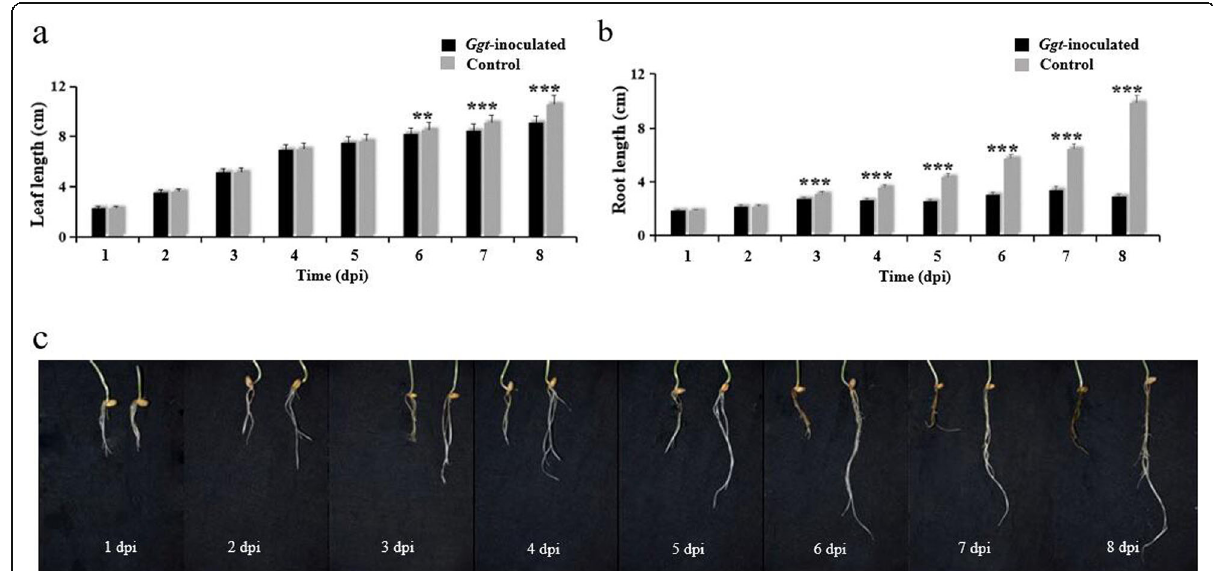
Fig. 1 Growth characteristics of wheat inoculated with Gaeumannomyces graminis var. tritici over a time course of 8 days. a Leaf length of wheat inoculated with Ggt . b Root length of wheat inoculated with Ggt . c Images of wheat roots inoculated with Ggt (left) and control roots (right). Asterisks indicated a statistically significant differences between Ggt -inoculated wheat and wheat (**, P < 0.005, ***, P < 0.0001) as determined by the Student